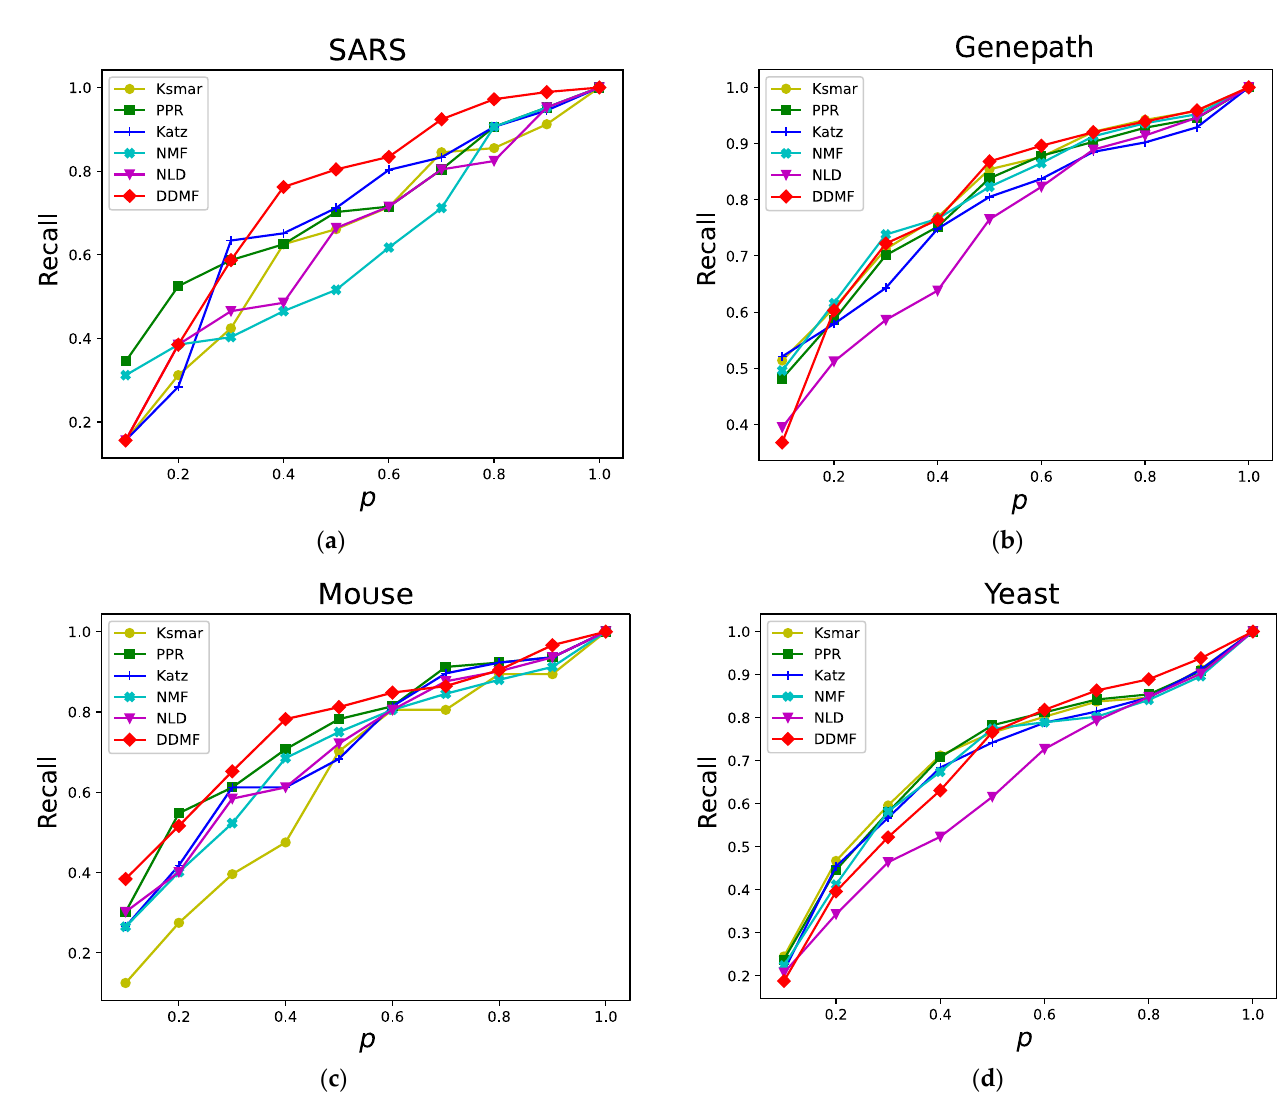
Figure 2. Precision rate results in four networks: ( a ) SARS network; ( b ) Genepath network; ( c ) Mouse network; ( d ) Yeast network.